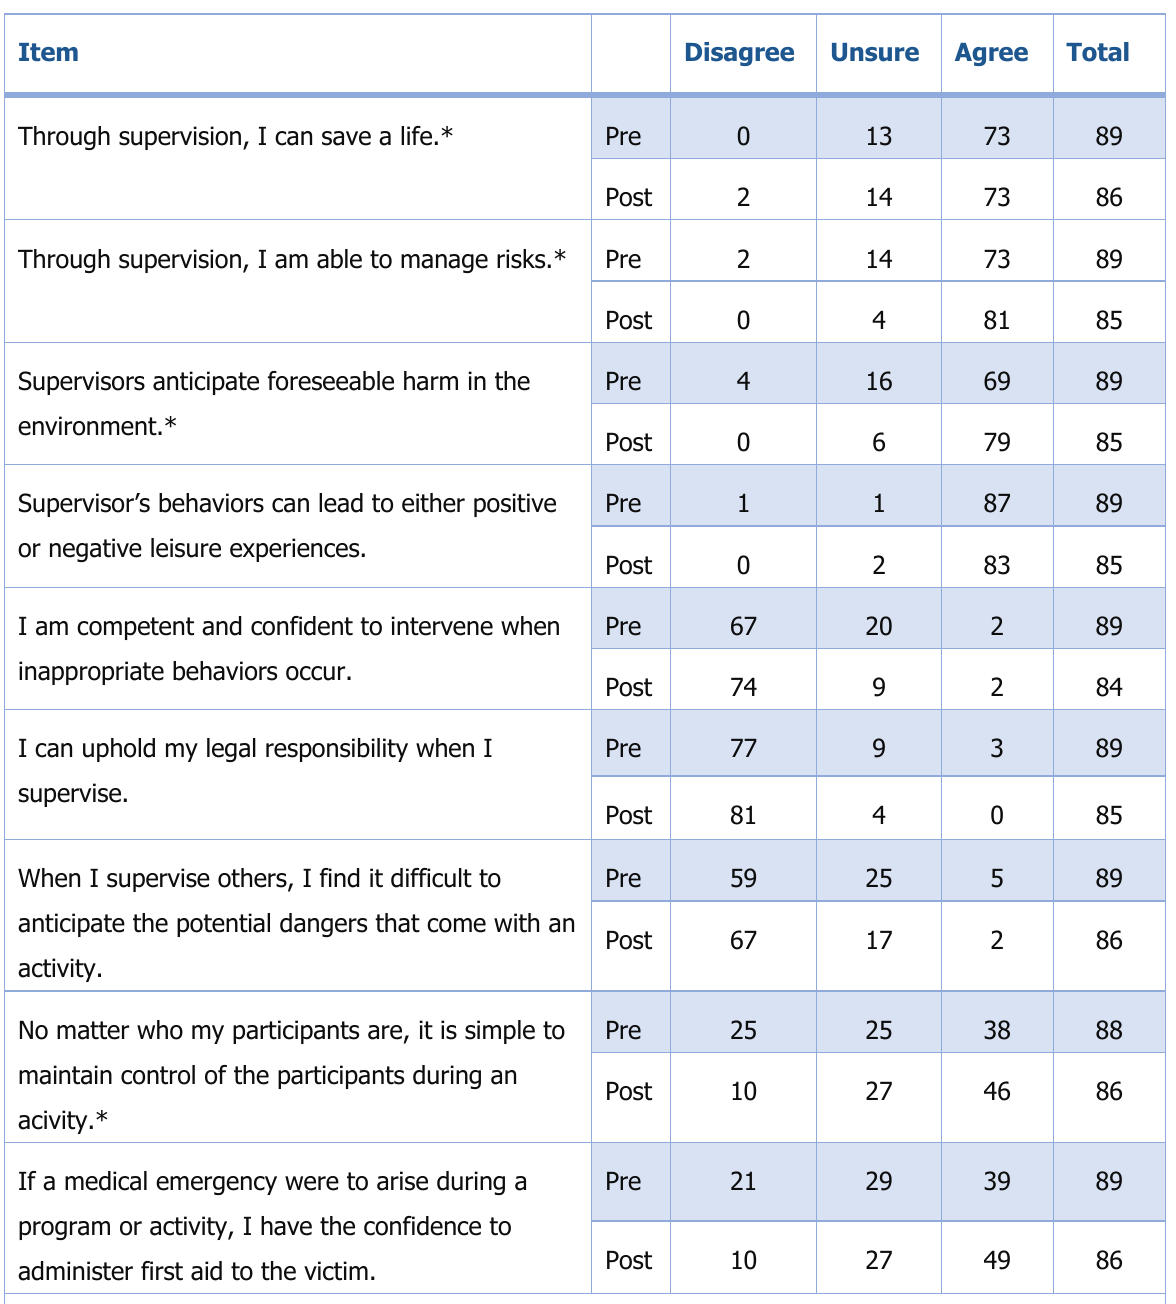
Table 2. Perceived Confidence in Ability to Engage in Risk-Management